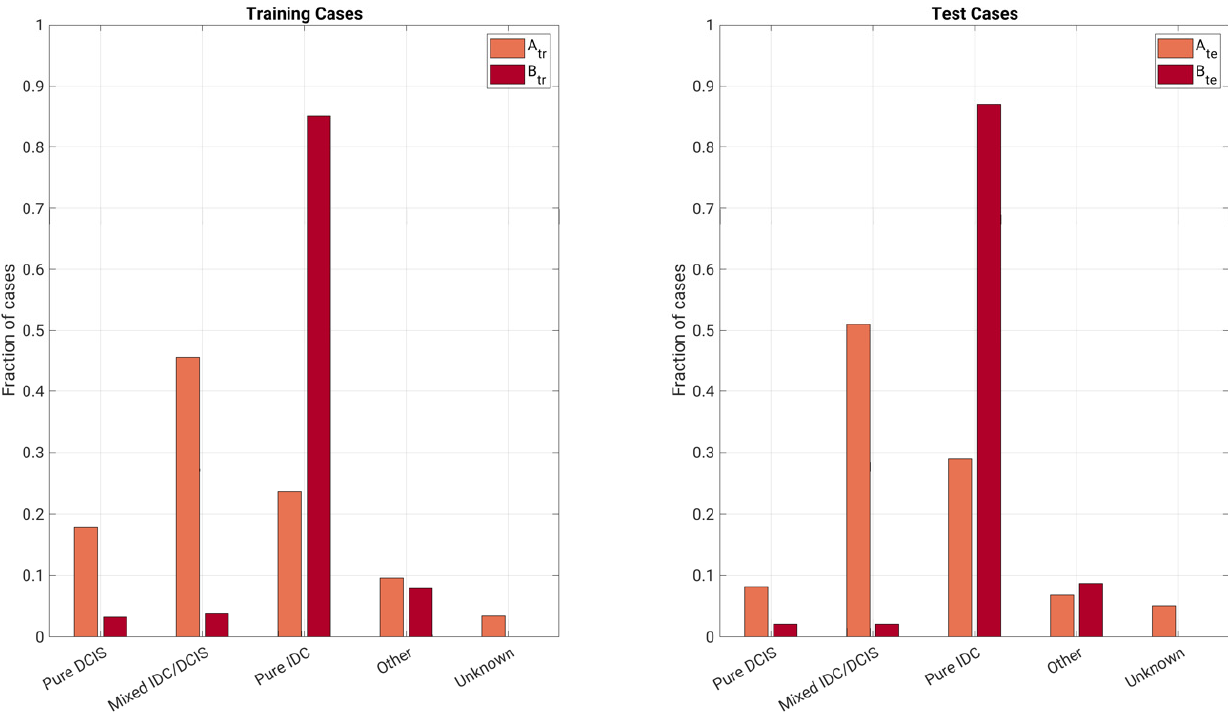
Figure 3. Description of the dataset: fraction of types of cancers (one lesion per case) by database (A: Database A; B: Data- base B; tr: training; te: test; DCIS: ductal carcinoma in situ; IDC: invasive ductal carcinoma).